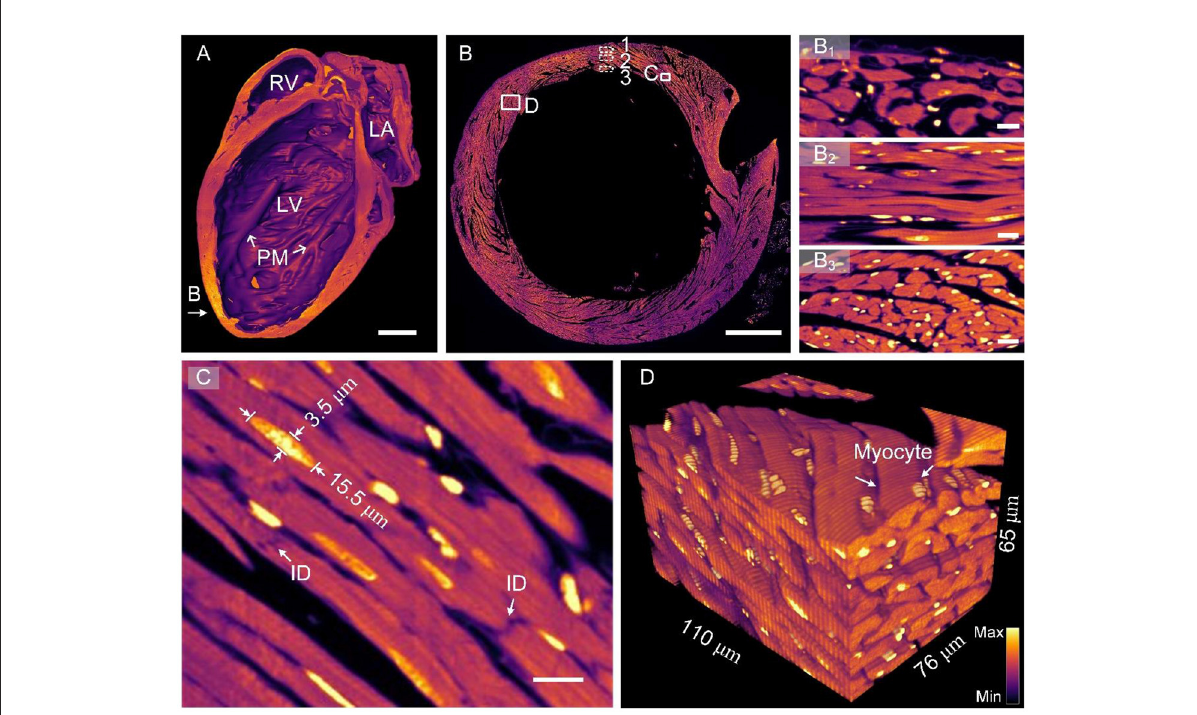
FIGURE2 Images of heart-wide myocardial architecture at single-cell resolution. (A) Sagittal section view of reconstructed whole-heart myocardial data. LA, left atrium; LV, left ventricle; RV, right ventricle; PM, papillary muscle. Scale bar: 1 µ m. (B) Original image of an axial section of the heart. (B 1 –B 3 ) display the cardiac muscle cells of the ventricular wall from the outside layer (epicardium), middle layer (myocardium), and inside layer (endocardium). Scale bars: 500 and 10 µ m, respectively. (C) Enlarged view of the corresponding rectangle in (B) . ID, intercalated disc. Scale bar: 10 µ m. (D) A reconstructed myocardial data block with a single resolvable myocyte.